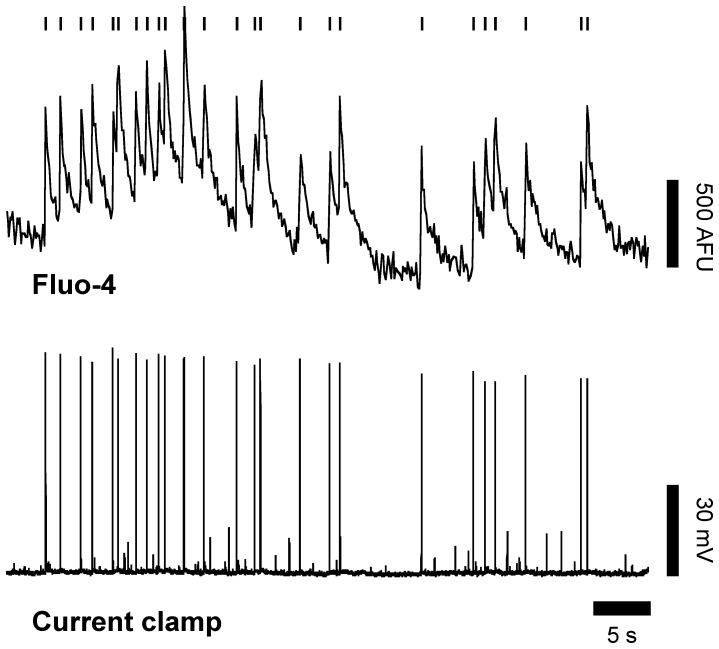
Neuronal activity monitored with calcium imaging.Comparison between simultaneous intracellular calcium imaging sampled at a frame rate of 10 Hz and whole-cell patch clamp recordings. A representative experiment out of 15 is shown with the upper trace representing calcium transients (arbitrary fluorescence units, AFU) and lower trace action potentials recorded in current-clamp configuration from the same neuron. The tick marks above the calcium trace indicate the occurrence of action potentials detected in the same cell using patch-clamp recordings.